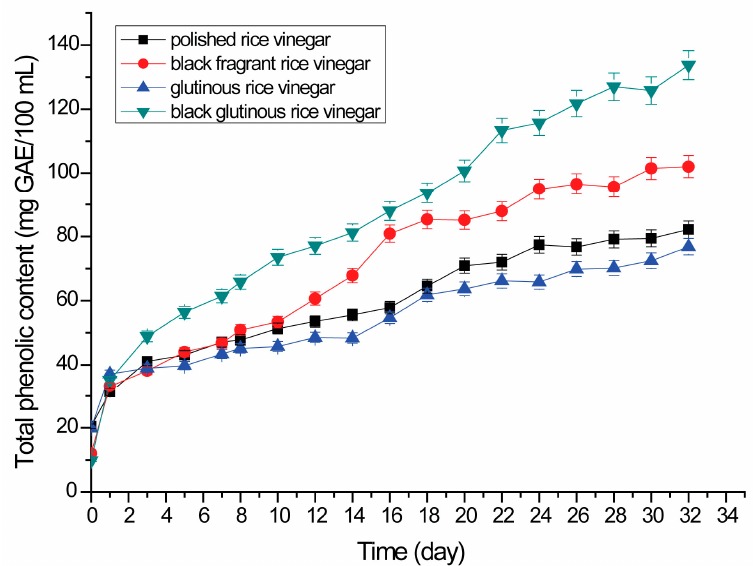
Figure 3. Total phenolic contents in rice vinegar during fermentation.